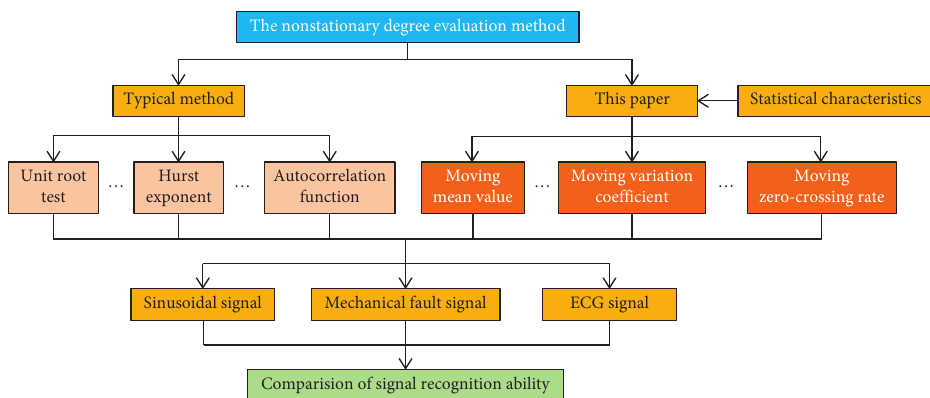
Figure 1: Block diagram of this paper